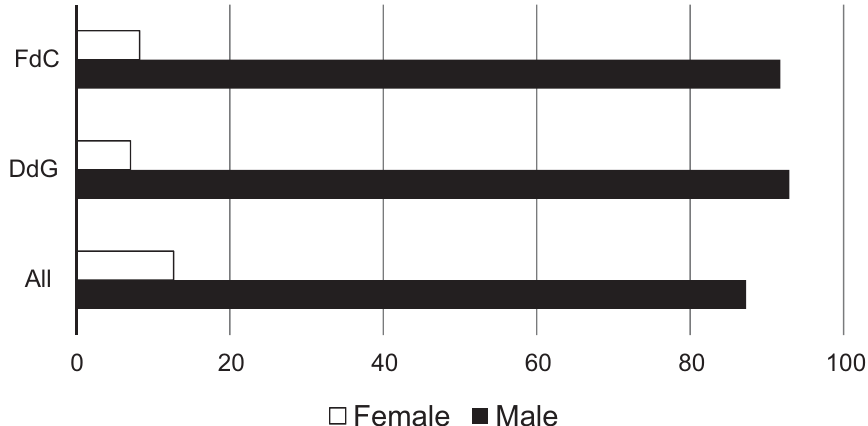
Figure 4 - Listeners’ gender in each of the SC podcasts analyzed and in podcasts in general. Fronteiras da Ciência (FdC, n = 473); Dragões de Garagem (DdG), n = 325); general mean for Brazilian podcasts (All, n =